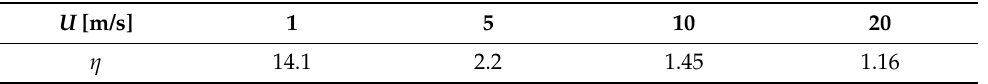
Table 1. Ratio of the estimates of the turbulence energy dissipation rate obtained with and without regard for the averaging of the radial velocity over the probing